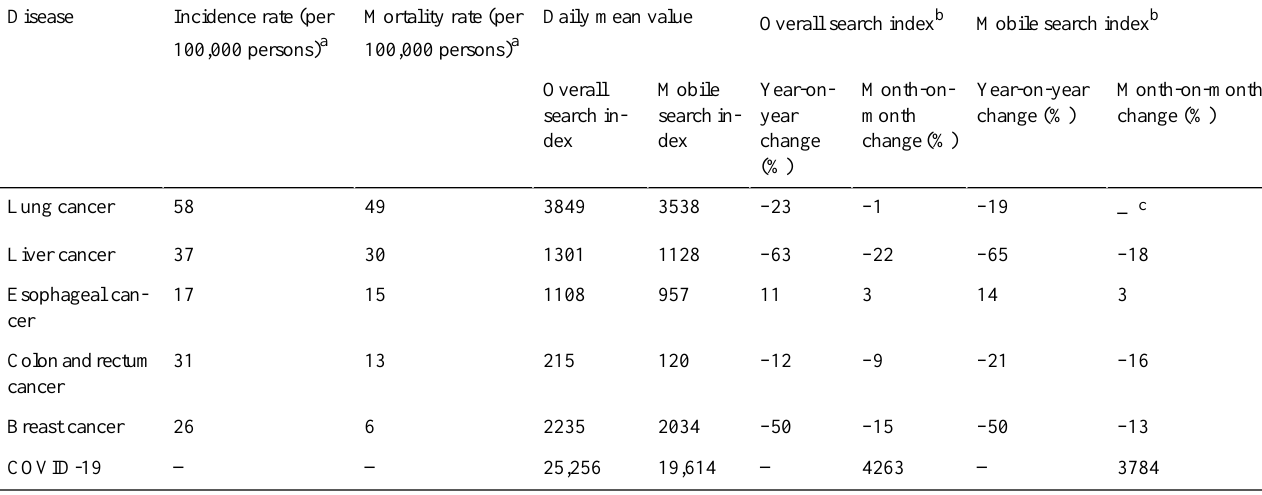
Table 2. Changes in the search index of the top five cancers and coronavirus disease (COVID-19) in China from January 27, 2020, to March 17,